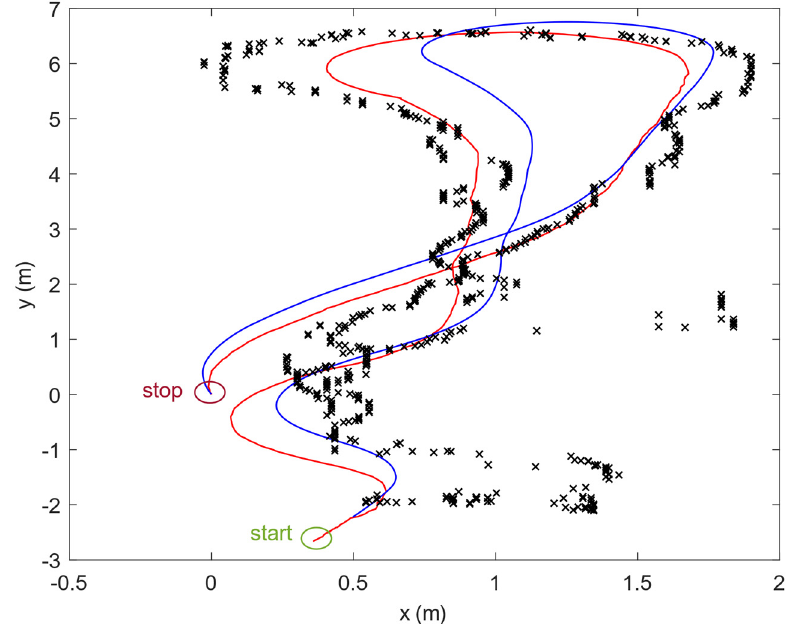
Figure 14. The trajectory determined by three methods in the environment “corridor part A.” Black points—UWB, red line—SLAM, blue line—dead reckoning.